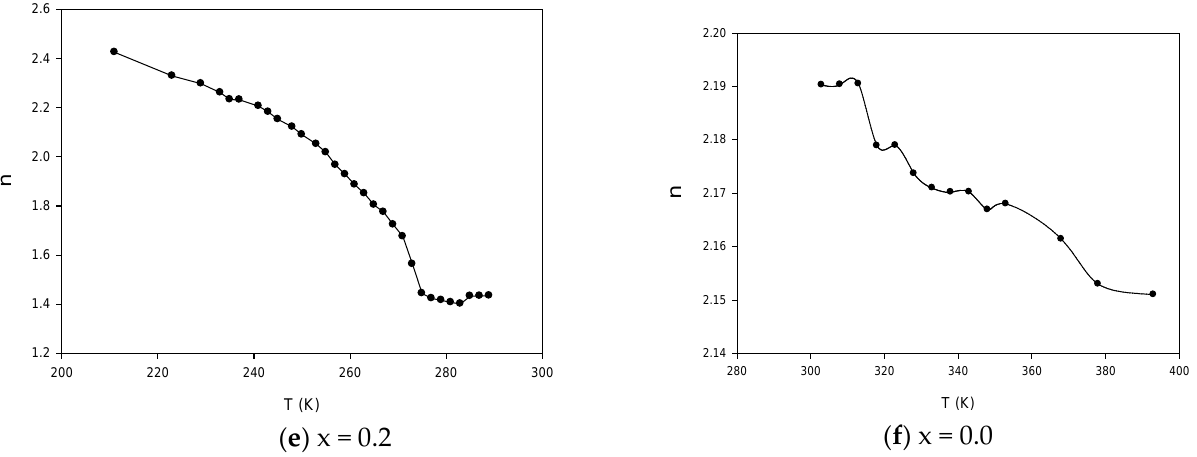
Figure 7. ( a – f ): The variation of exponent (n) for the composites of (PVDF-BZT) as a function of temperature at 1 KHz.